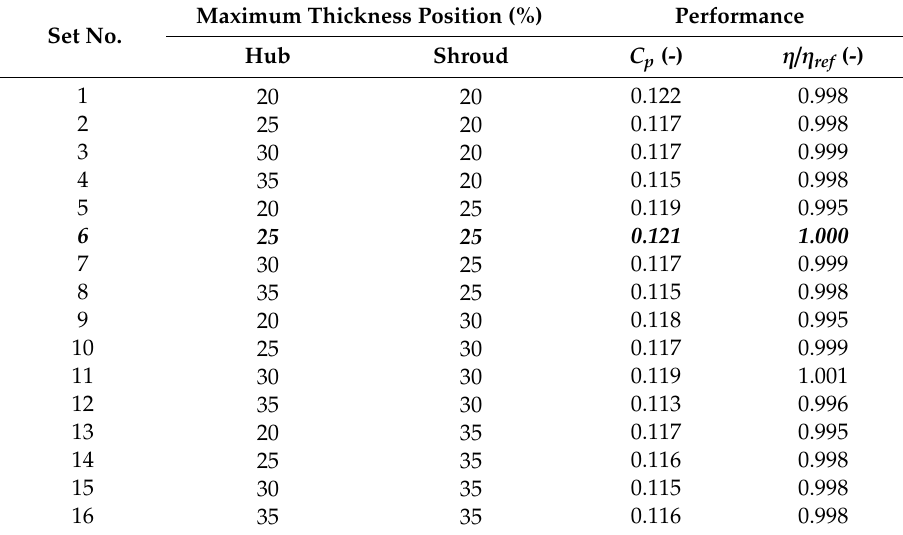
Table 2. Maximum thickness position and performance of each sensitivity analysis set. Set